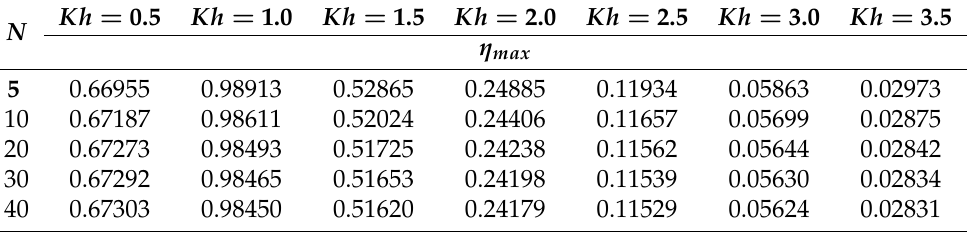
Table 1. Convergence of the maximum hydrodynamic efficiency η max computed by using the EEM for different numbers of evanescent modes N with a 1 / h = a 2 / h = 0.5, w 1 / h = w 2 / h = 0.125 b / h = 1.0 and h e / h = 1 without the reflecting vertical wall.